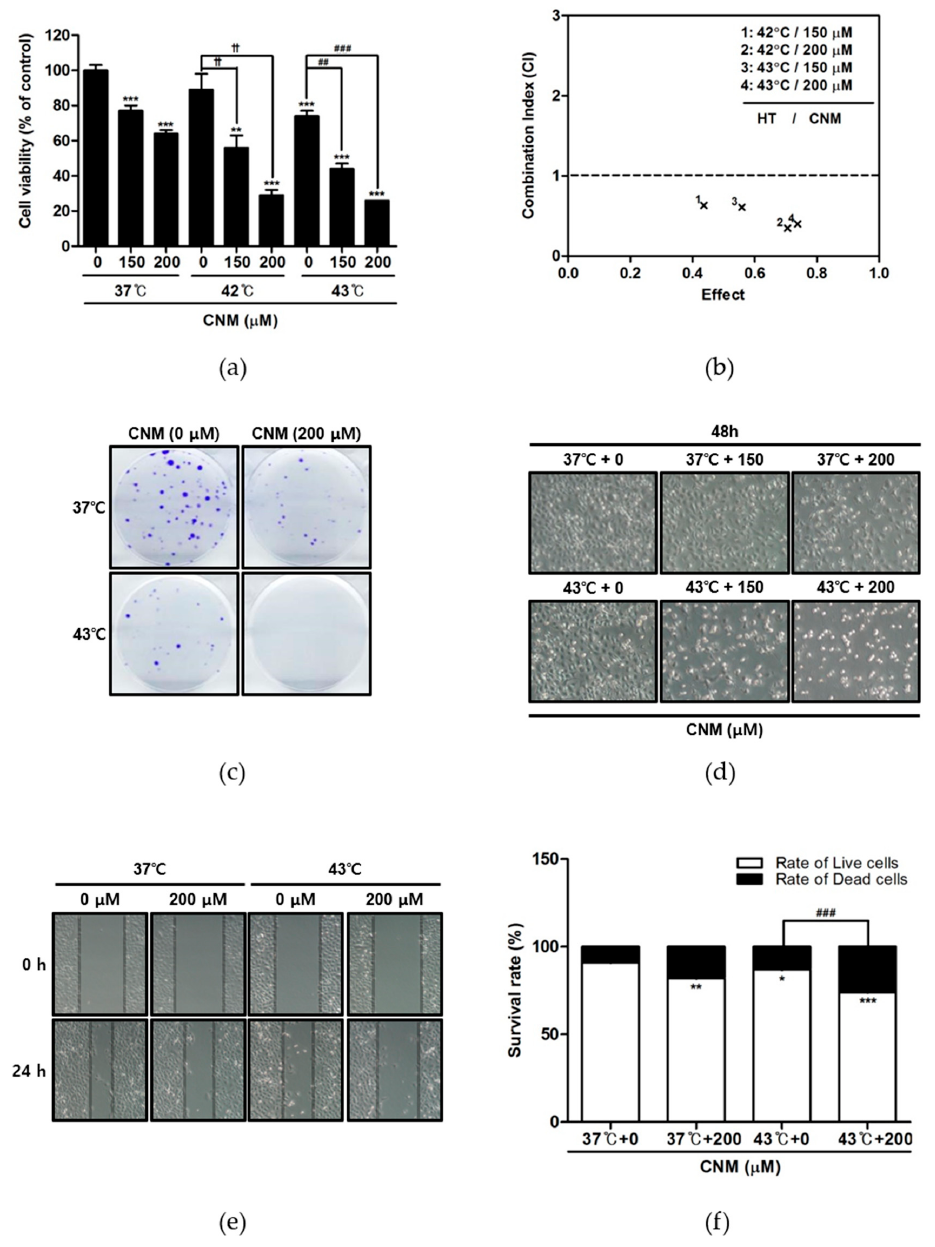
Figure 2. E ff ect of CNM and hyperthermia combination therapy on cell viability in A549 cells. A549 cells were treated with CNM (0, 150 or 200 µ M) with or without hyperthermia and incubated for 24 h. ( a ) The cell viability was determined by an MTT assay. ** p < 0.01, *** p < 0.001 vs. 37 ◦ C + 0 µ M group; †† p < 0.01 vs. 42 ◦ C + 0 µ M group; ## p < 0.01, ### p < 0.001 vs. 43 ◦ C + 0 µ M group; ( b ) The combination index on cytotoxicity e ff ect was determined using CompuSyn Software; ( c ) a clonogenic assay was performed by staining cells with Crystal violet staining; ( d ) morphological changes reflecting apoptosis were visualized under a regular light microscope (magnification × 100); ( e ) wound healing assays were performed; ( f ) the live and dead cell portion was determined by Trypan blue staining. * p < 0.05, ** p < 0.01, *** p < 0.001 vs. control group; ### p < 0.001 vs. 43 ◦ C + 0 µ M group.